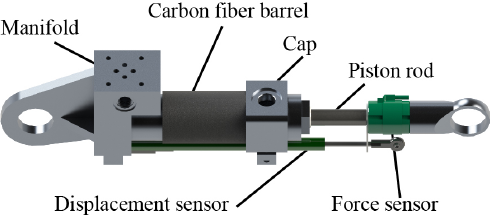
Figure 4. The actuator designed by our laboratory.